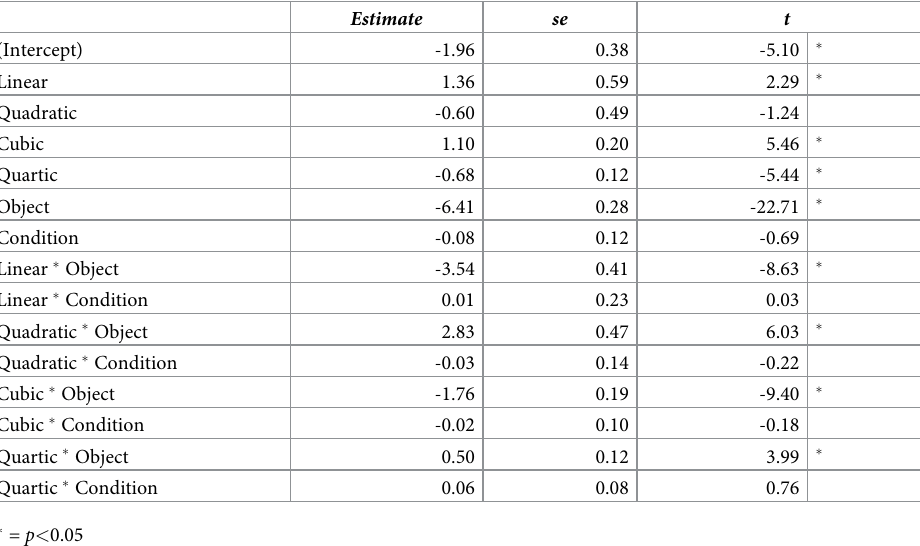
Table 1. Main and interaction effect in the quasi-logistic GCA mixed model analysis in Experiment 1B.